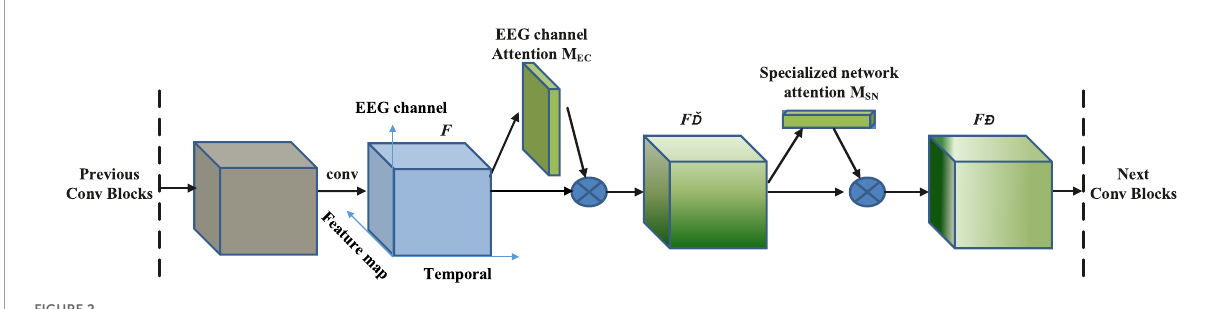
refined by the EEG channel-wise attention sub-module. These are the dot multiplication results of the 2D EEG channel- wise attention map M EC and the original feature map